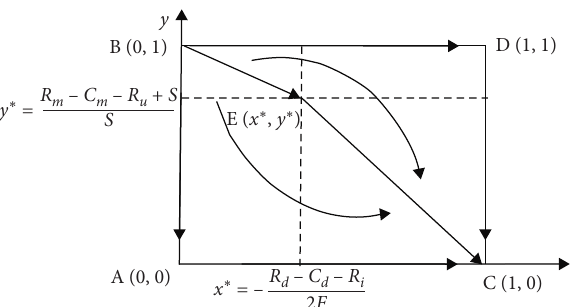
Figure 6: The replication dynamic phase map for scenarios (3) and